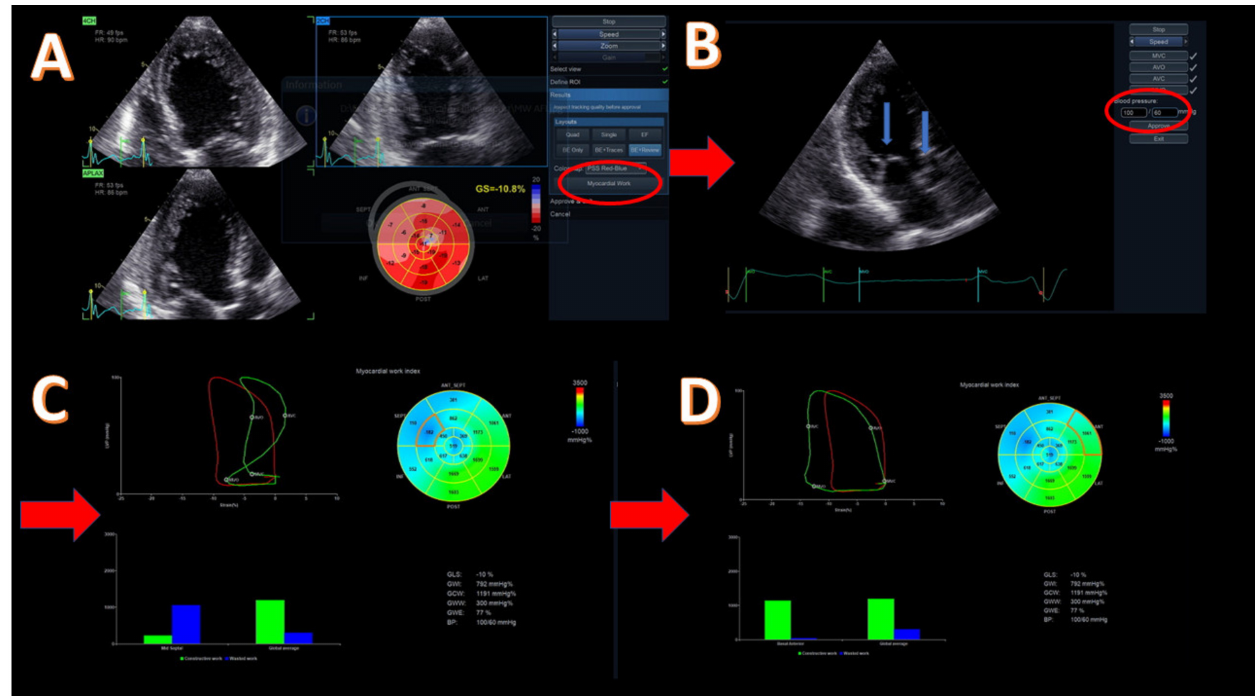
Figure 2. Methodology of myocardial work (MW) for a patient with reduced ejection fraction (EF = 30%) due to cardiotoxicity. ( A ) Acquisition of apical four-, two-, and three-chamber view and evaluation of global longitudinal strain (GLS) with left ventricular (LV) bull’s eye; GLS = − 10.8%. The highlighted button (with red circle) moves to the next step for myocardial work evaluation. ( B ) Introduction of systolic and diastolic blood pressure (red circle) and confirmation of the correct event timing in apical three-chamber view. The blue arrows point to mitral and aortic valves that should be clearly demonstrated. ( C ) Evaluation of global values of all MW components, including bull’s eye of the work index, global pressure–strain loop (red loop), and segmental pressure–strain loop (green loop), showing a dyssynchronous mid-septum segment and bars showing the relationship between the constructive (green bar) and wasted (blue bar) segmental (left) and global work. ( D ) Evaluation of the same global values as in image C but with different segment for pressure–strain loop analysis and with constructive/wasted work bars. Basal anterior segment with constructive work similar to the global one. Red arrows show the next step of the